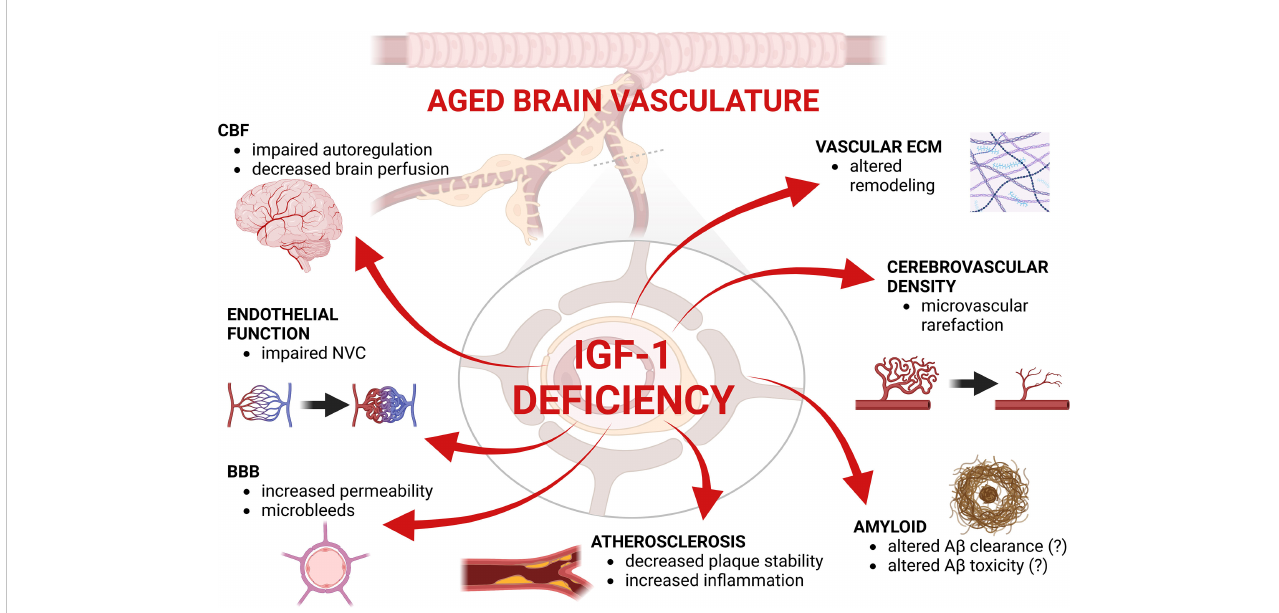
FIGURE 2 Summary fi gure highlighting the effects of IGF-1 de fi ciency in the aged brain vasculature. CBF, Cerebral blood fl ow; ECM, extracellular matrix; BB, blood- brain barrier; NVC, neurovascular coupling. Created with